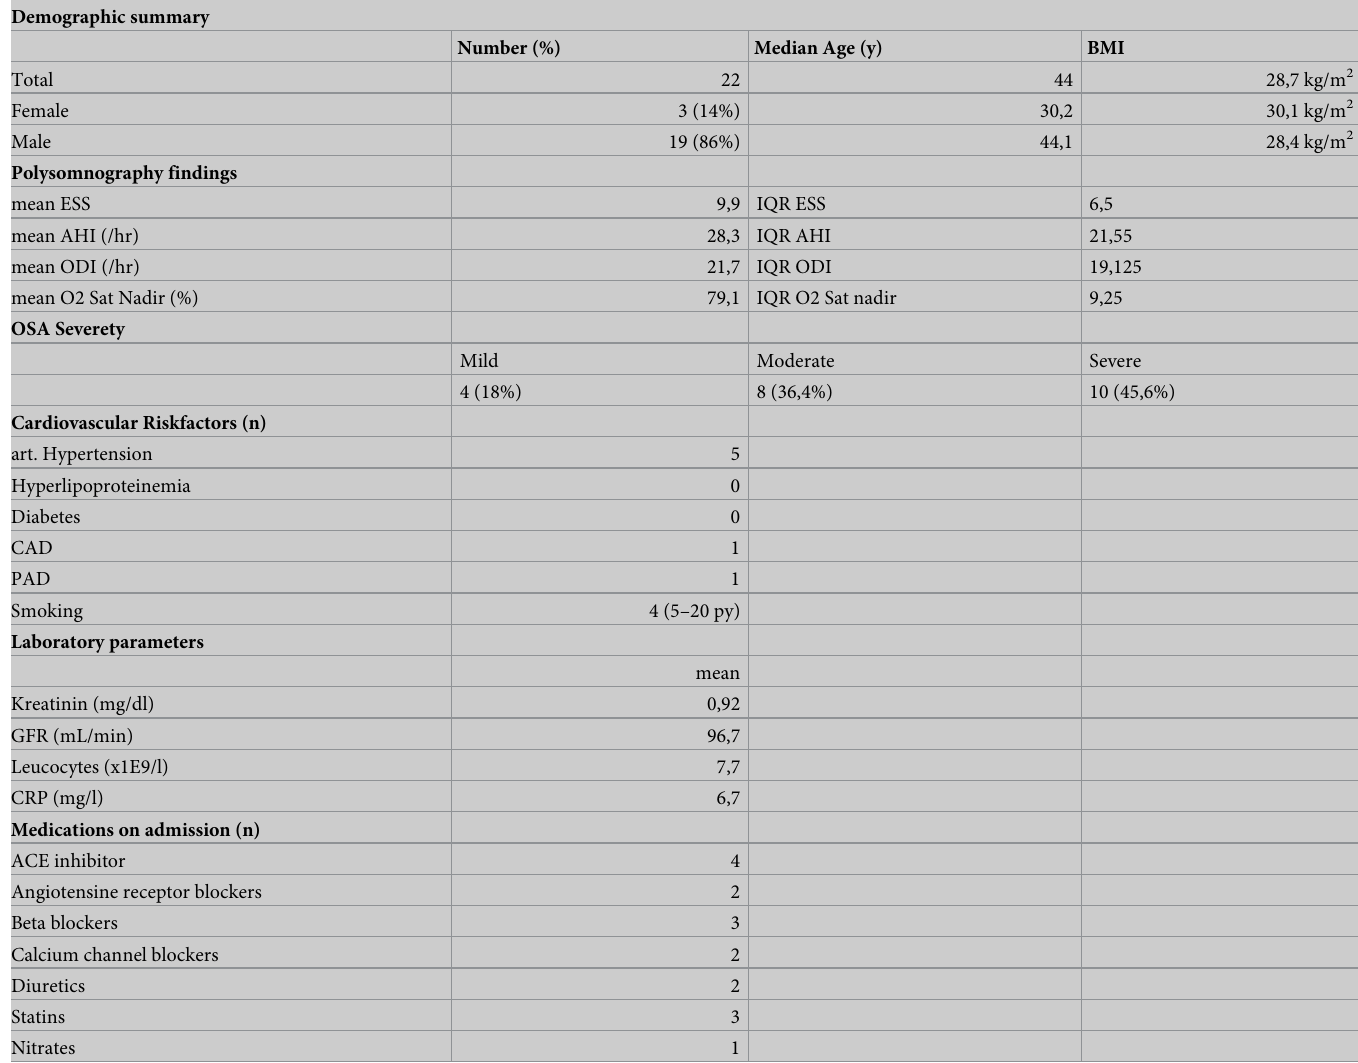
Table 1. Baseline